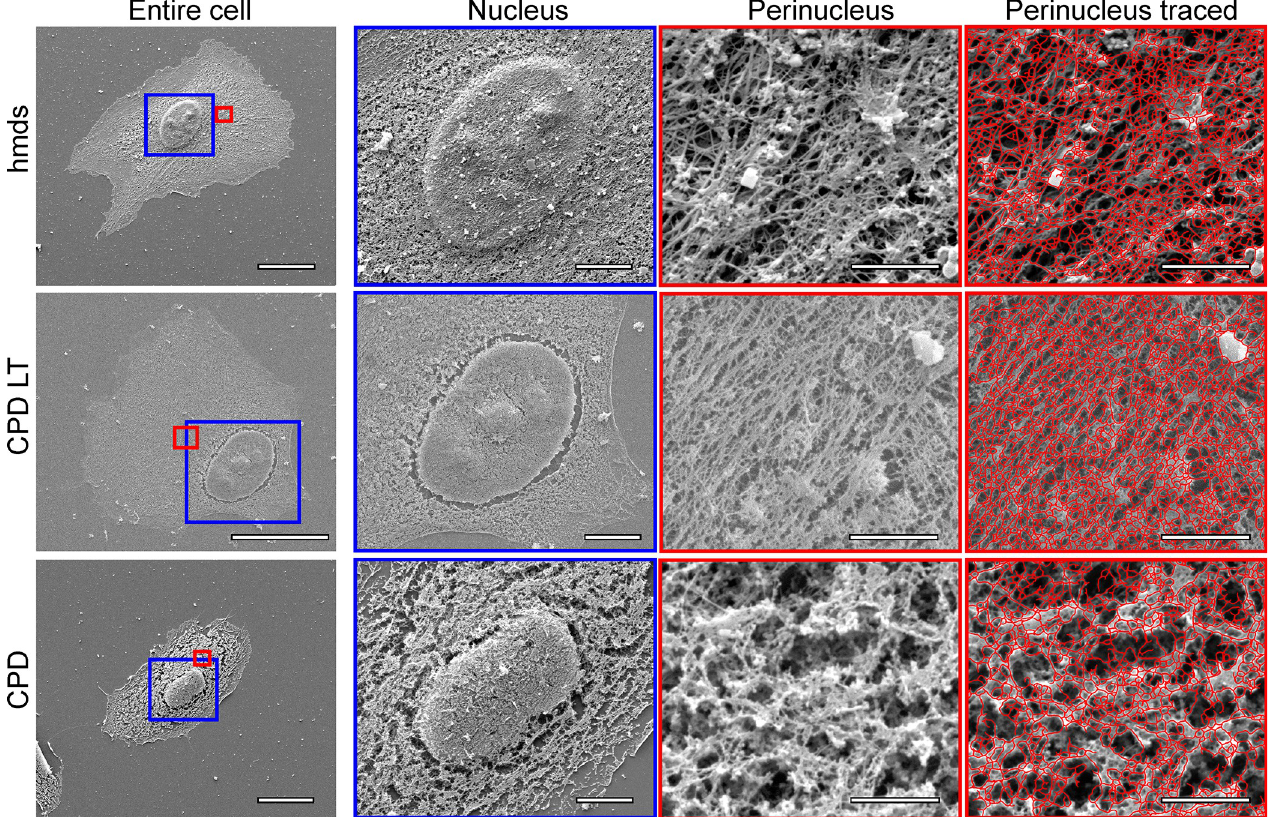
Fig 1. Representative scanning electron microscopy images of the cells following HMDS10 drying, and CPD-LT and CPD. Entire cell: whole cell images; magnification, 5k × . Blue boxes, areas defined for nucleus images; red boxes, areas defined for perinucleus images. Nucleus: magnification, 10 × . Perinucleus: magnification, 80k × . Perinucleus traced: with software vectorial tracing (red); magnification, 80k × . Scale bars: 20 μ m (entire cell); 5 μ m (nucleus); 1 μ m (perinucleus, perinucleus tracing).